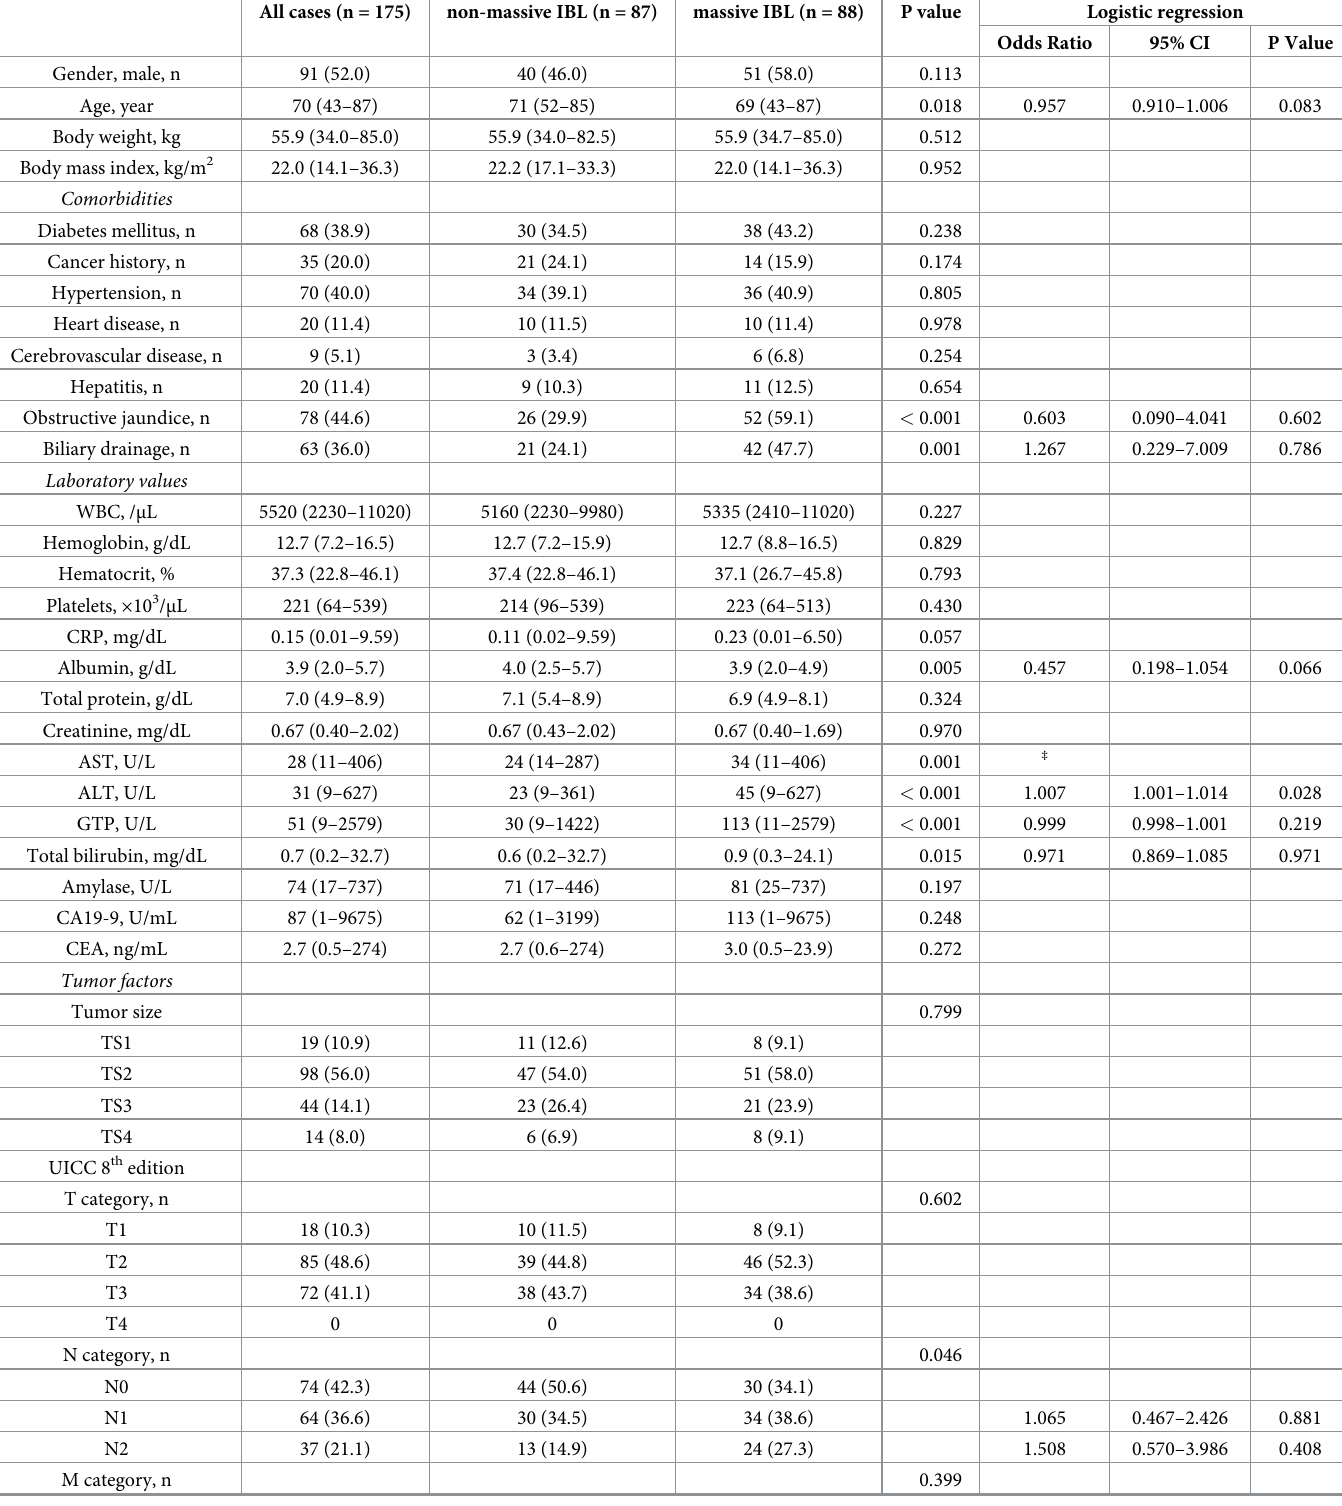
Table 3. Comparison of the perioperative characteristics of massive IBL and non-massive IBL